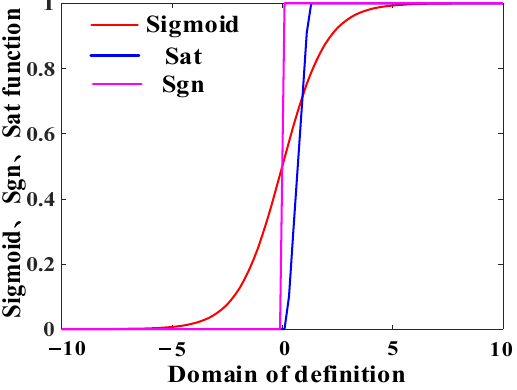
Figure 10. Sigmoid, sat and sgn functions.